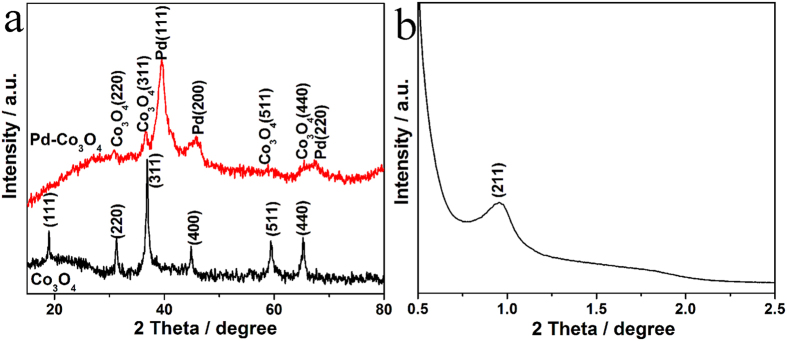
(a) XRD patterns for mesoporous Co3O4 and Pd-Co3O4 (wt 1:1) catalysts; (b) low-angle XRD pattern for mesoporous Co3O4.